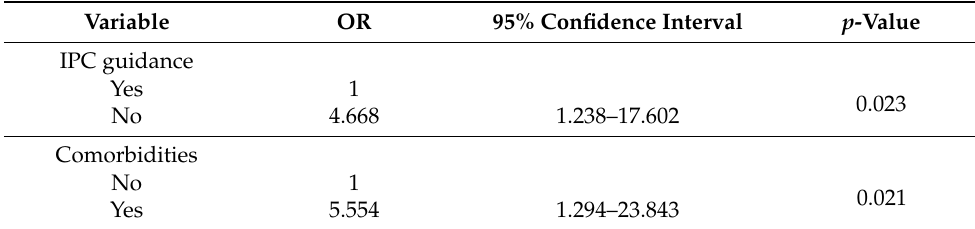
Table 4. Odds of febrile neutropenia according to multivariate logistic regression